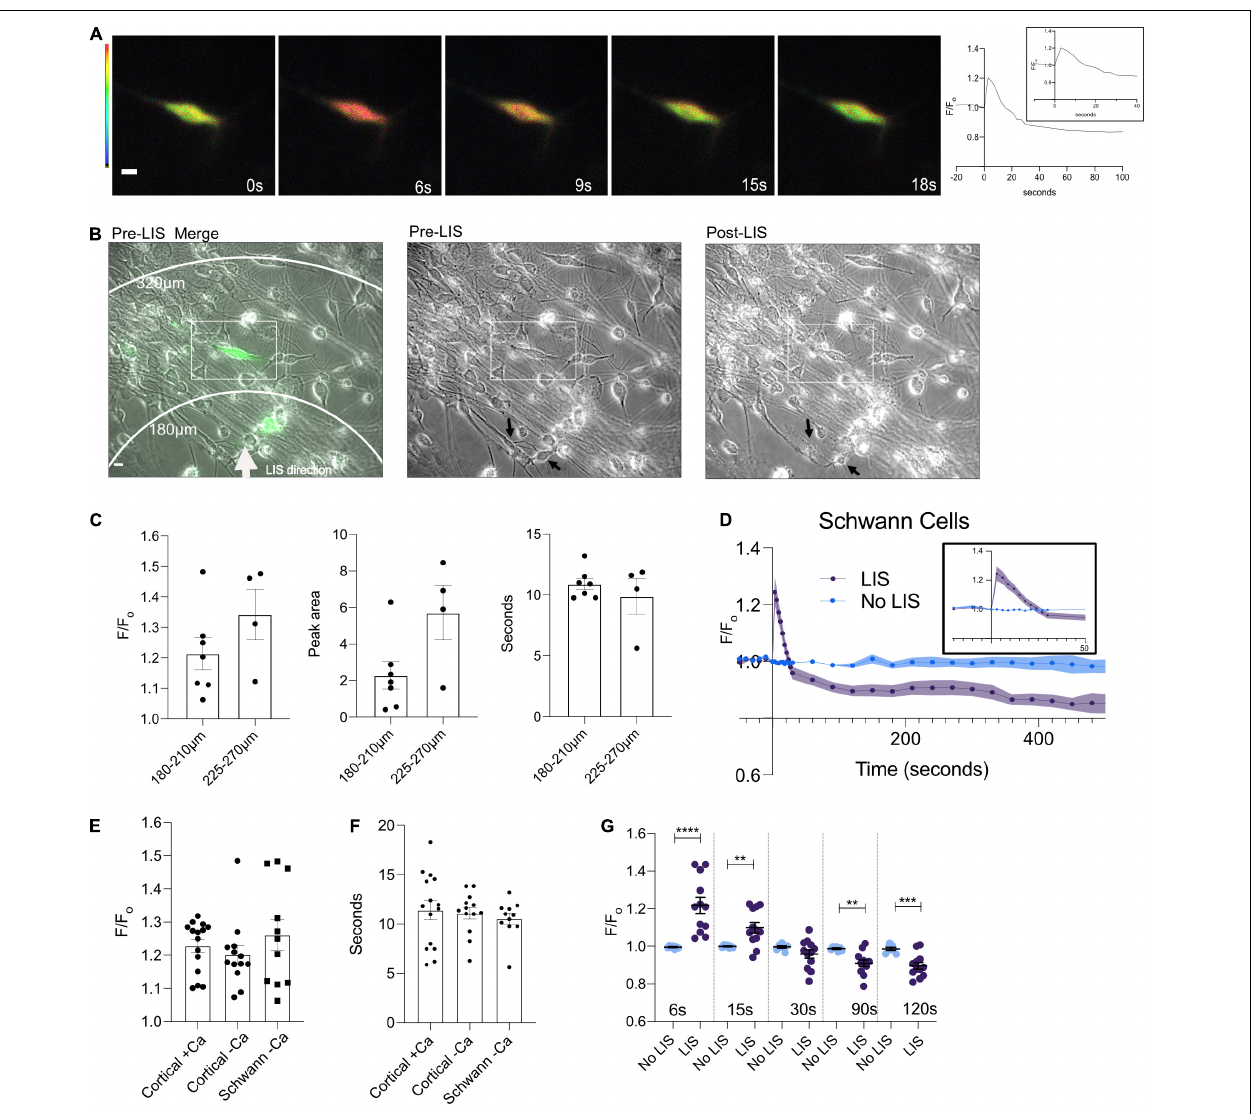
FIGURE 4 | A DIV 9 Schwann cell exhibits a calcium transient in response to the shockwave. (A) Ratiometric images of cells pre (0 s) and 6, 9, 15, and 18 s post shockwave show that following a shockwave internal calcium increases as demonstrated by a magenta color. Scale bar = 10 µ m. Images taken 15 and 18 s post-LIS show that the cell has returned to pre-LIS levels. The corresponding F/F o Ca 2 + trace is shown to the right. (B) Phase and ratiometric images were overlaid. A white arrow points in the direction of LIS propagation. Scale bar = 10 µ m. A rectangle is enclosing the cell that was quantified in this field. On the right of the merged image are individual pre- and post-LIS images. Black arrows are pointing to cells that appear affected by LIS. The top arrow points to a cell that appears faint after LIS and whose processes are no longer clear. The bottom arrow points to a cell which appears to have rounded after LIS. (C) F/F o , peak area, and time to reach the half-maximum of Schwann cells separated by distances of 180–210 and 225–270 µ m. No statistical differences were found between groups at different distances. However, one cell in the 180–210 µ m group had a large F/F o of 1.48 which also corresponded to the outlier in the peak area comparison. (D) Average F/F o for Schwann cells with ( n = 11 cells) and without shockwave ( n = 7) in low Ca 2 + . (E) Individual F/F o values of the Ca 2 + transient peak for cortical neurons and Schwann cells from DRG ( ∼ 6 s) after the shockwave. No statistical differences were found between cells. F/F o = 1.23 ± 0.02, 1.20 ± 0.03, 1.26 ± 0.05 for cortical cells in regular Ca 2 + ( N = 15), cortical cells in low Ca 2 + ( N = 13), and Schwann cells ( N = 11), respectively. (F) The length of time it takes to reach the half maximum ( t -half) is shown by cell type. The average t-half for cortical cells in calcium is 11.4 ± 0.96 s and low calcium is 11.1 ± 0.59 s. For Schwann cells from DRG, the average t -half is 10.6 ± 0.53 s. (G) F/F o for individual cells are plotted at different times. Statistical differences are seen between cells that were shockwaved and those that were not. **** p = 0.0001, *** p = 0.001, ** p = 0.01.